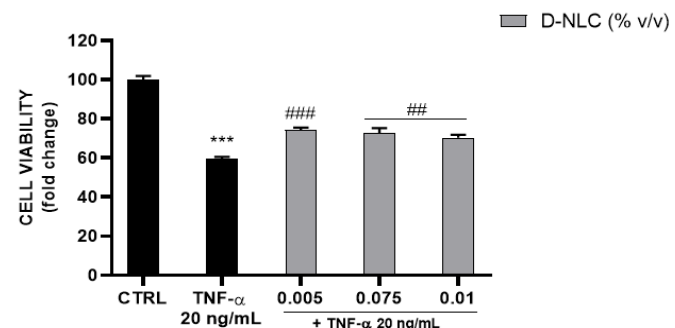
Figure 14. Evaluation of TNF- α (20 ng/mL) effect on ARPE-19 cell viability and recovery with co-treatment of TNF- α and D-NLC 160 µ M (*** p < 0.0005 vs. CTRL; ### p < 0.0005, ## p < 0.005 vs. TNF- α).